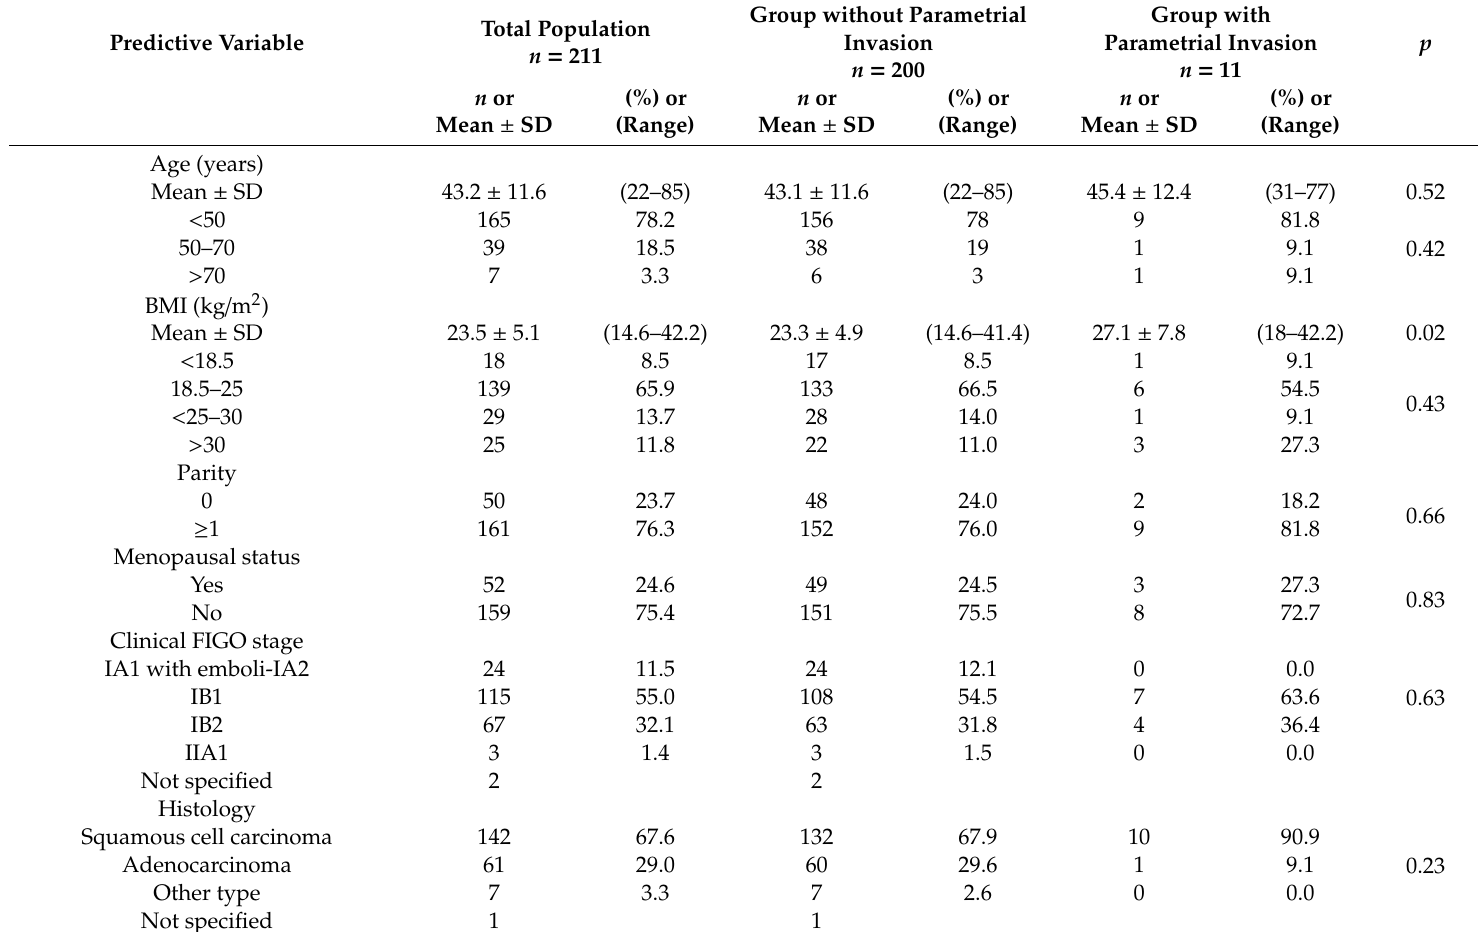
Table 1. Patient characteristics in the total population, group with and group without parametrial involvement in early stage cervical cancer.